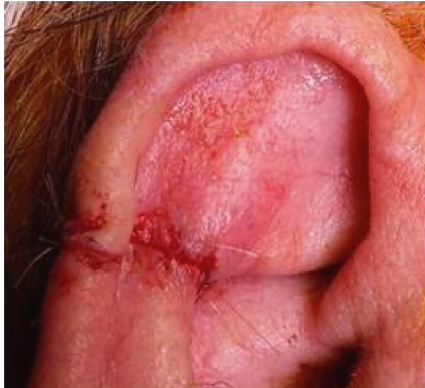
Figure 3: Clinical photograph showing right pinna after wedge excision of the initial nodular lesion and primary wound